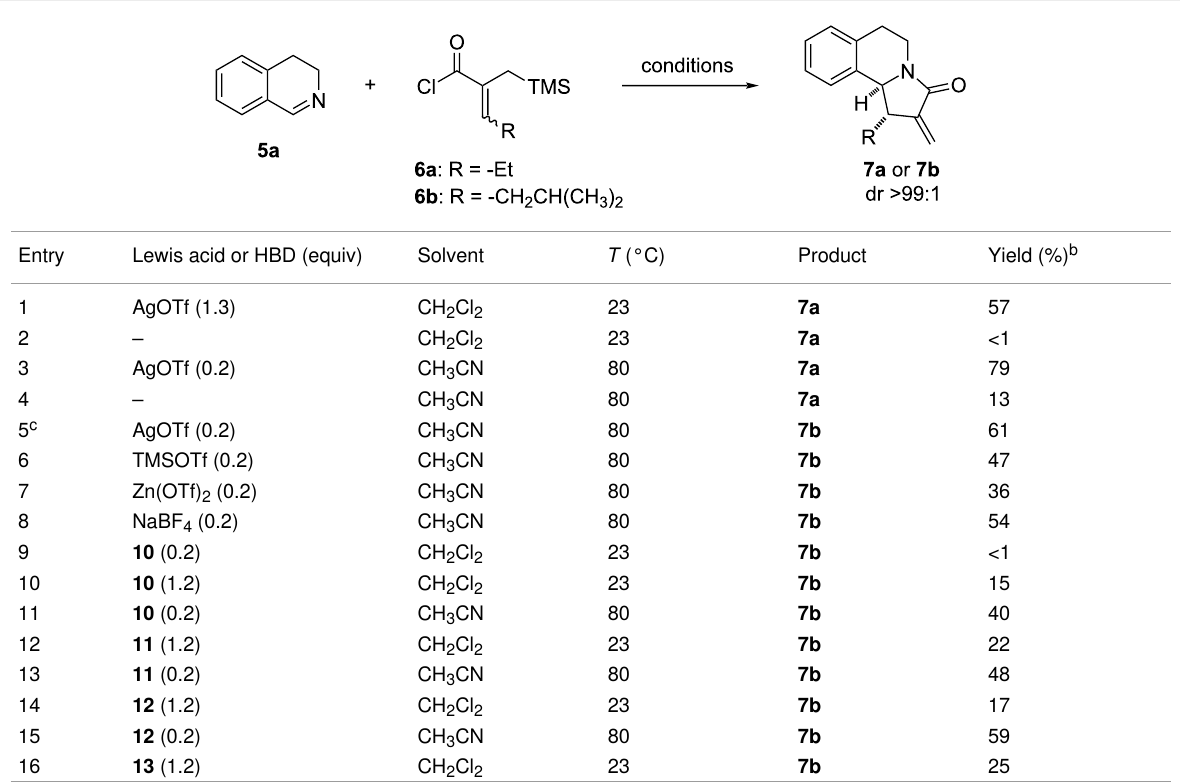
Table 1: Screening of Lewis acids and hydrogen-bond donors (HBD) for the aza-Nazarov cyclization. a